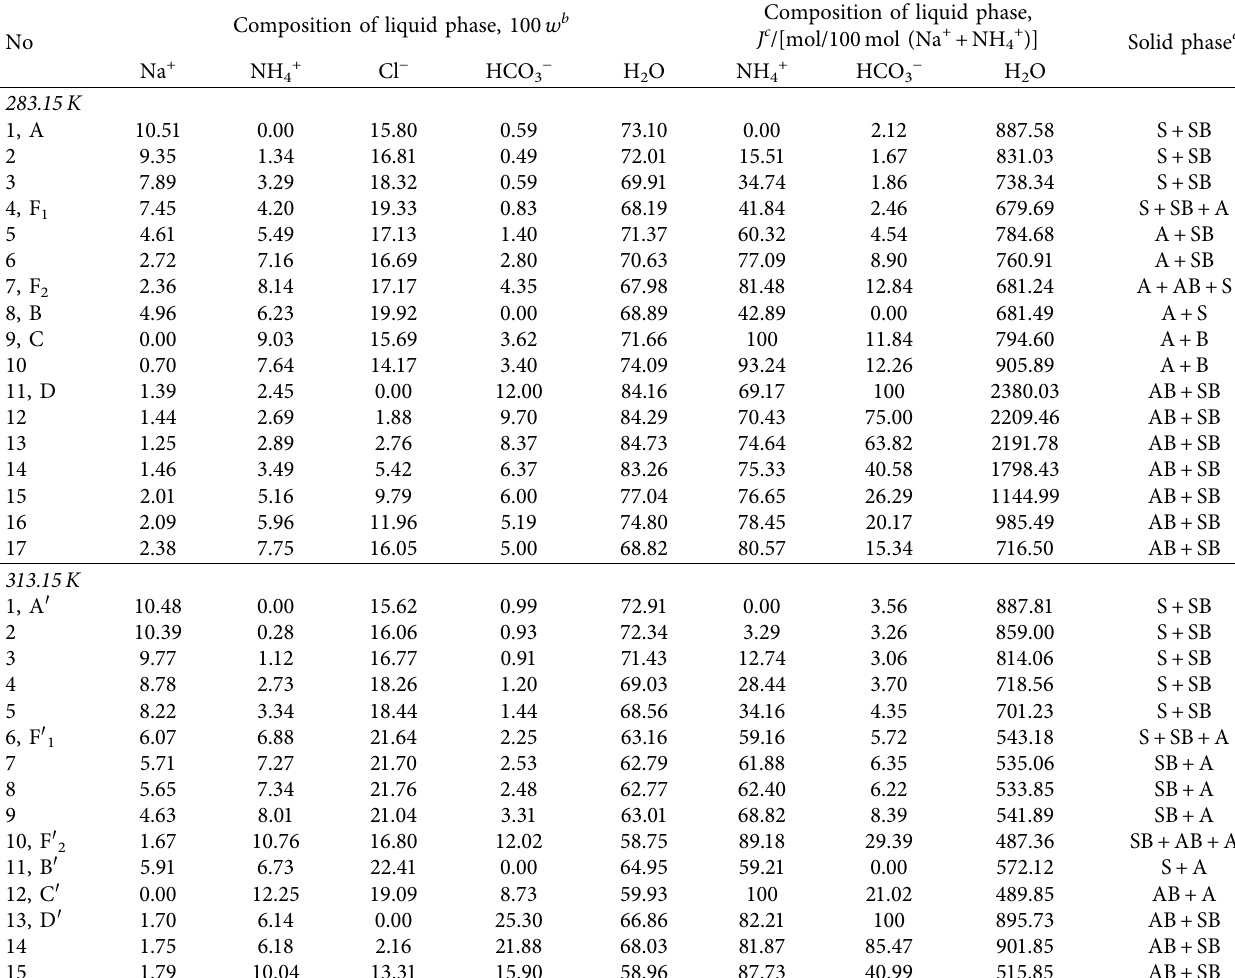
Table 3: Solubilities and physicochemical properties in the quaternary system (NaCl+NH 313.15K, and 0.1 MPa a